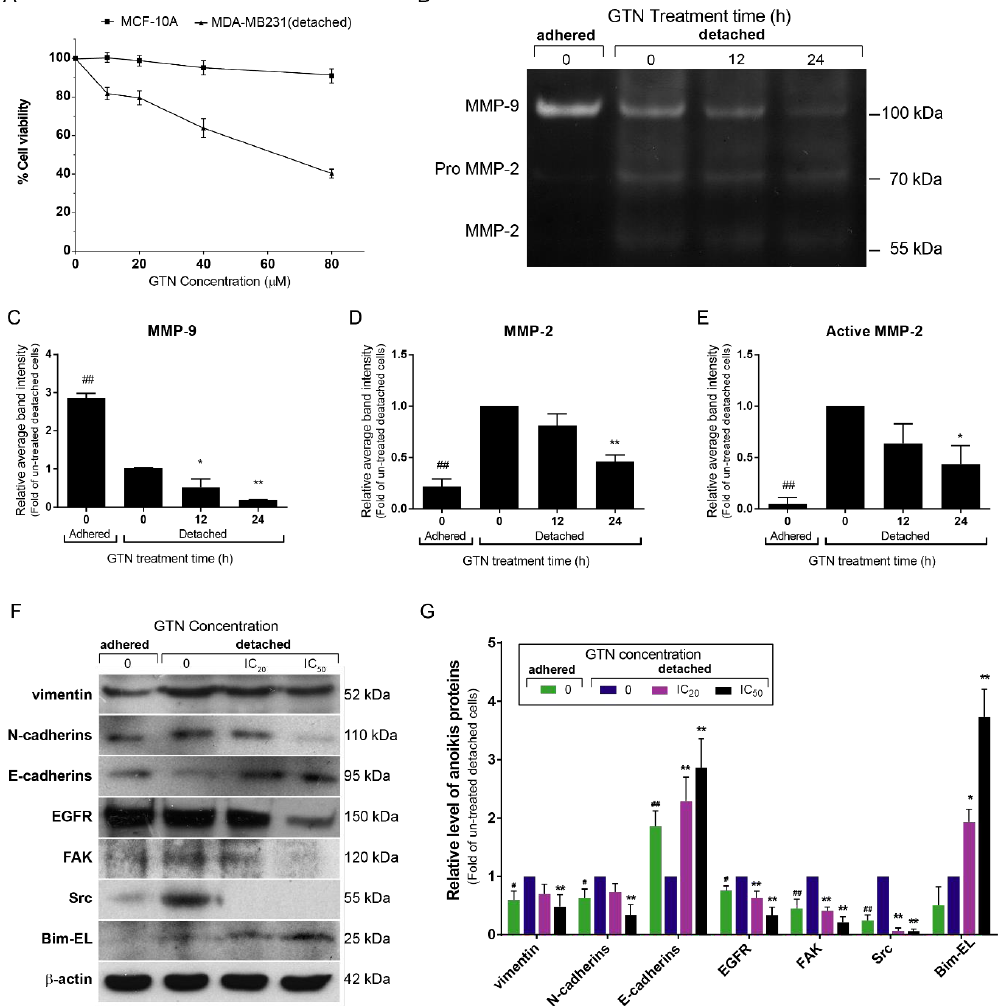
Figure 5. GTN-induced anchorage-independent MDA-MB-231 cell anoikis programmed cell Figure 5. GTN - induced anchorage-independent MDA - MB - 231 cell anoikis programmed cell death . The cell viability of detachment MDA - MB - 231 cell condition, cultured in a poly - HEMA coated plate